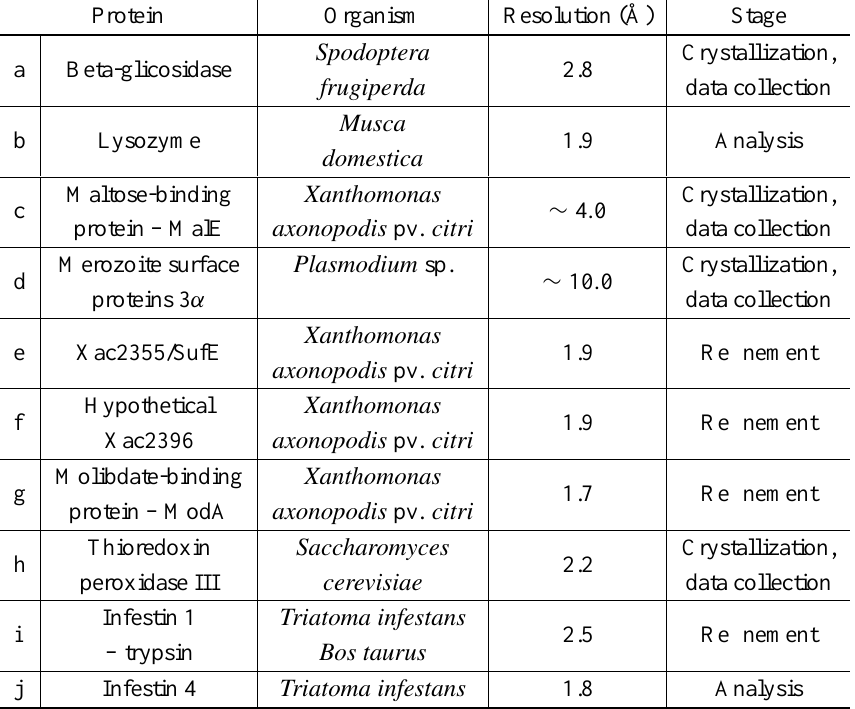
Name of the proteins, organism, maximum diffraction resolution and current research stage of the crystals shown from Figure 1. The letters “a” to “h” on the left of the protein’s column correspond to the letters in Figure